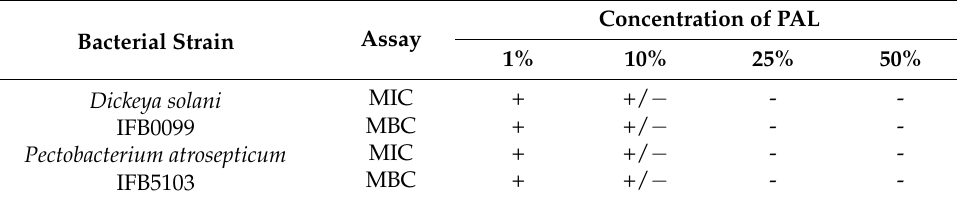
Table 4. Antibacterial properties of the plasma-treated 0.5% NH 4 NO 3 solution against phytopathogens. Bacterial